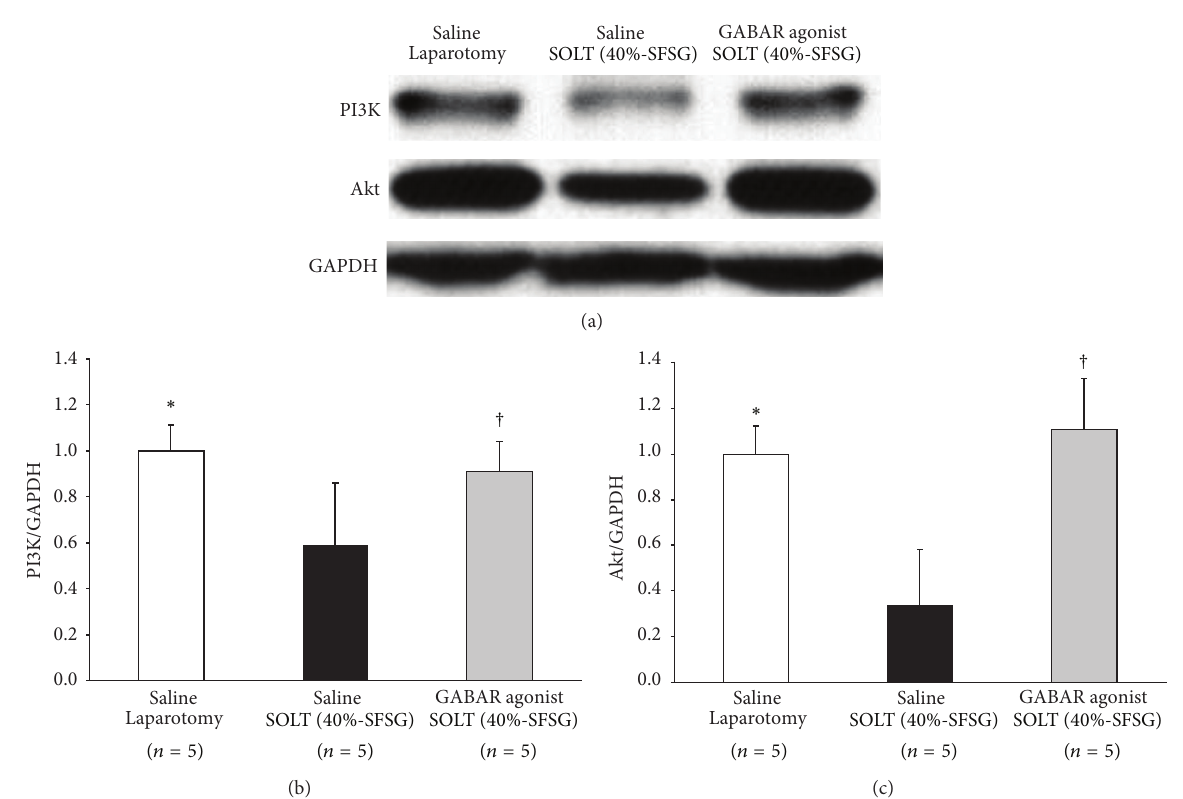
Figure 7: Western blot analyses of PI3K and Akt. (a) Intensities of PI3K. Akt, and GAPDH. (b) Normalized PI3K: There were significant differences between laparotomy and SOLT with saline ( 𝑃 < 0.05 ∗ ) and between SOLT with saline and SOLT with GABAR agonist ( 𝑃 < 0.05 † ). (c) Normalized Akt. There were significant differences between laparotomy and SOLT with saline ( 𝑃 < 0.05 ∗ ) and between SOLT with saline and SOLT with GABAR agonist ( 𝑃 < 0.05 † ). GABAR, 𝛾 -aminobutyric acid receptor; GAPDH, glyceraldehyde-3-phosphate dehydrogenase; PI3K, phosphatidylinositol-3 kinase; SFSG, small-for-size graft; and SOLT, split orthotopic liver